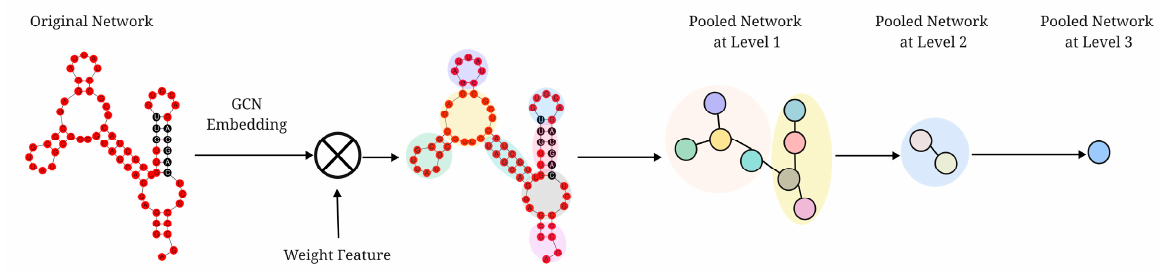
Figure 3. Structure diagram of the DiffPool model. In the DiffPool model, nodes of the same color overlaying the previous layer of the graph structure are aggregated into nodes of the same color in the next layer of the graph to form a coarsening graph.